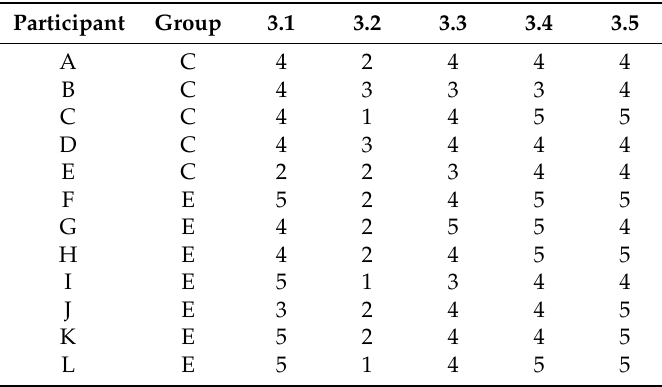
Table A10. Interim-survey section results 3/3.